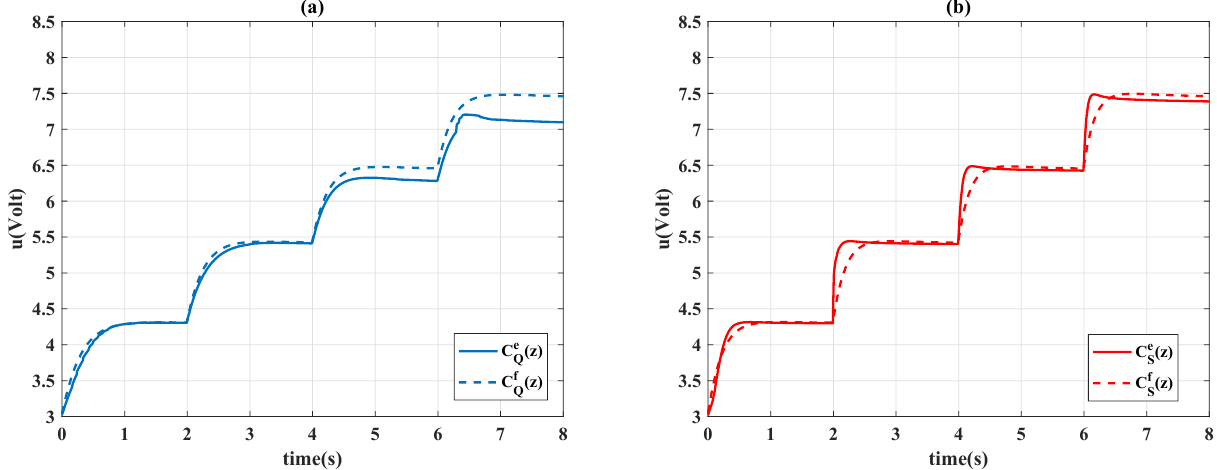
( z ) and C f ( z ) ; ( b ) Sarsa C 1 Q Q